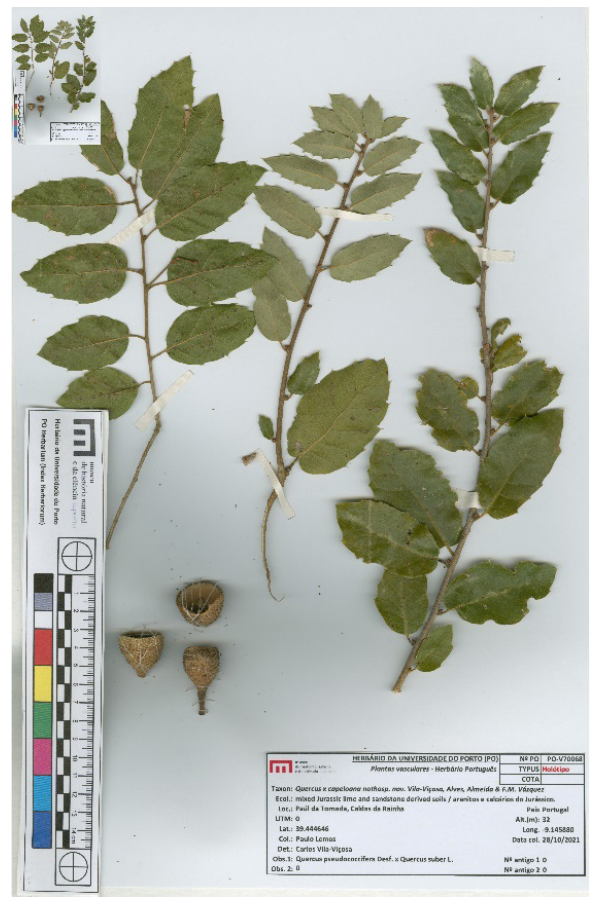
Figure 7. Holotype of Quercus ×capeloana Vila-Viçosa; P. Alves, P. Lemos, R. Almeida & F.M. Vázquez nothosp. nov. (PO-V70068!) (Porto University, Natural History and Science